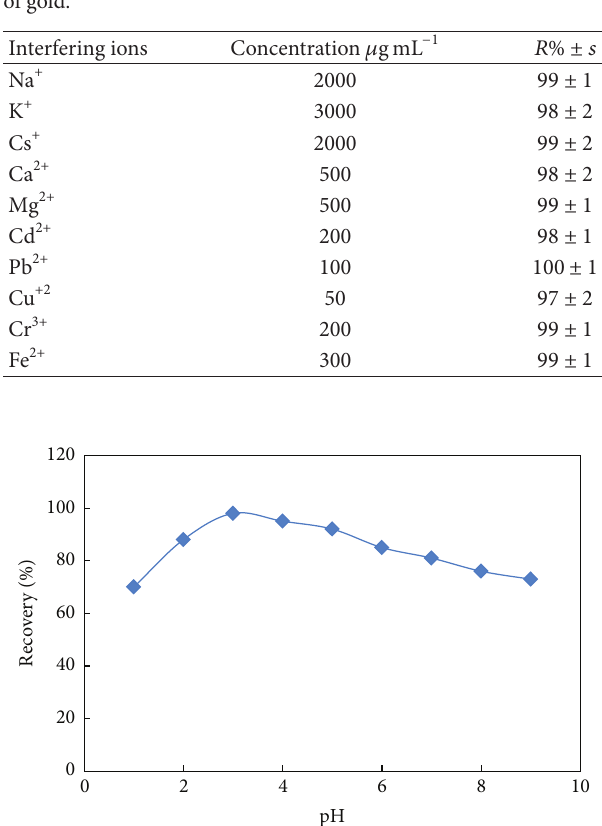
was not complete (Figure −1